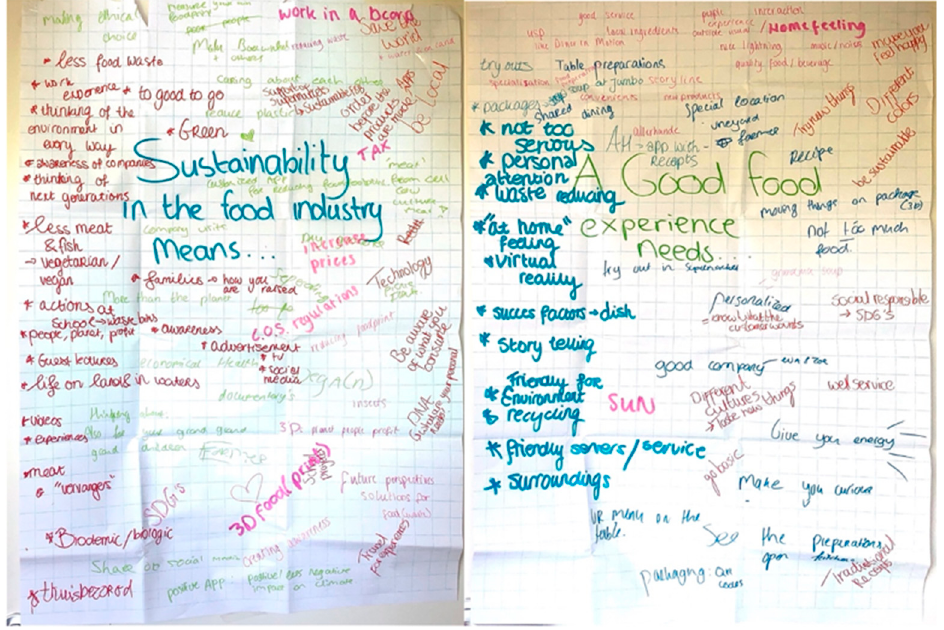
Figure 1. Illustration of Graffiti